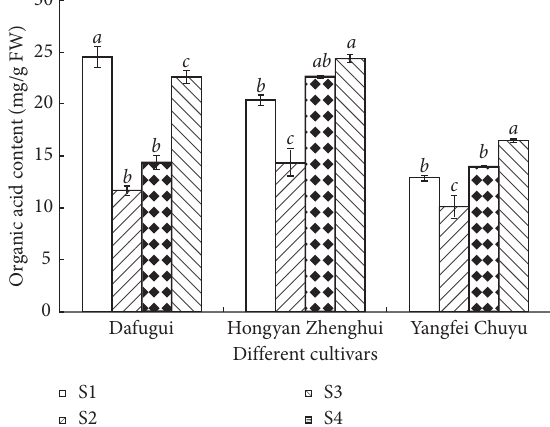
Figure 3: Organic acid content of developmental P. lactiflora petals (mg/g FW). Different letters within each cultivar indicated sig- nificant differences at 5%